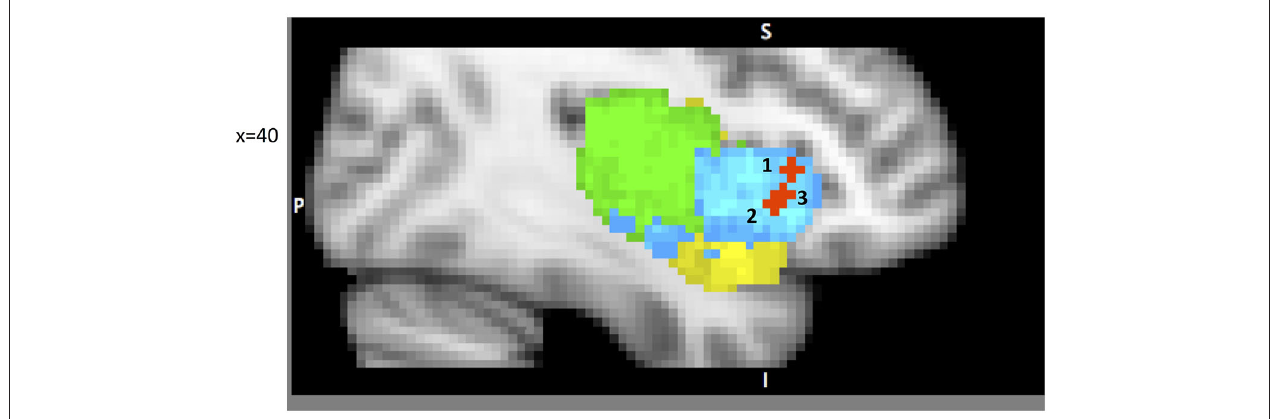
FIGURE 2 | A sample of studies addressing the IC’s role in Attention Focusing Phase (for illustration purposes only). Sub-regions of the Insula: posterior (green), dorsal anterior (blue) and ventral anterior (yellow). 1 – IC as part of the CCN in Cole and Schneider (2007) (38, 22, 5); 2 – IC as part of task-set system in Dosenbach et al. (2006) (40, 19, − 3); 3 – IC as part of Salience Network (SN) in Sridharan et al. (2008) (34, 26, −